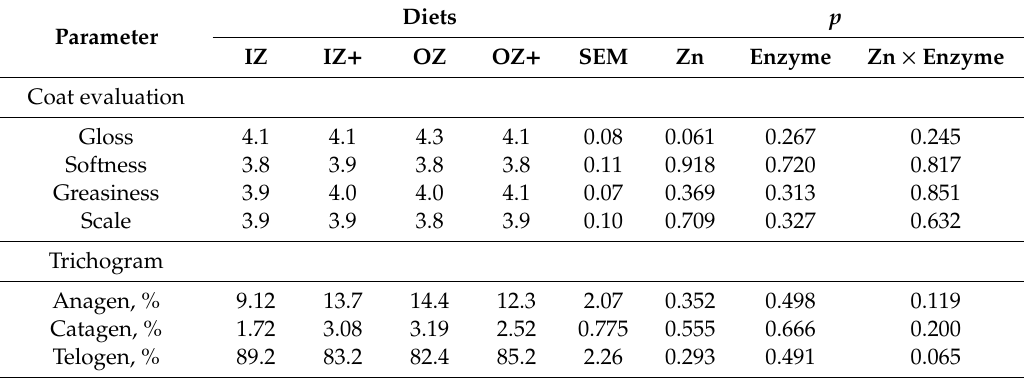
Table 7. Visual and sensorial coat evaluation and hair growth assessment (trichogram) of dogs fed the experimental diets.